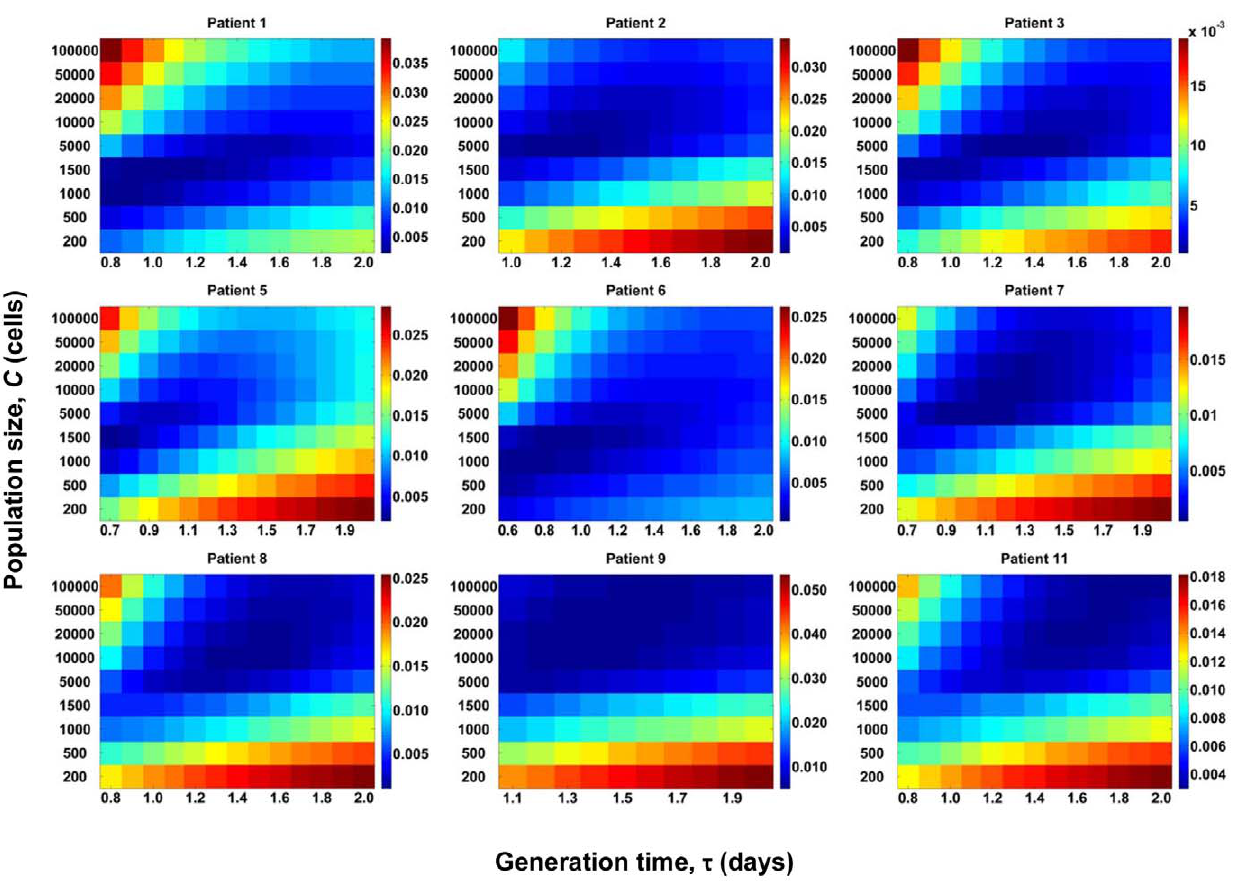
Figure 6. Estimation of N e from comparisons with data from patients. Sum of squares of the errors (SSE) between data from patients [36] and our predictions of viral diversity, d G , and divergence, d S , for different values of the population size, C , (Fig. 5) and the viral generation time, t , shown for each of the nine patients. C and t that yield the lowest SSE provide the best fit to the data. The best-fit value of C yields N e (Table 1).